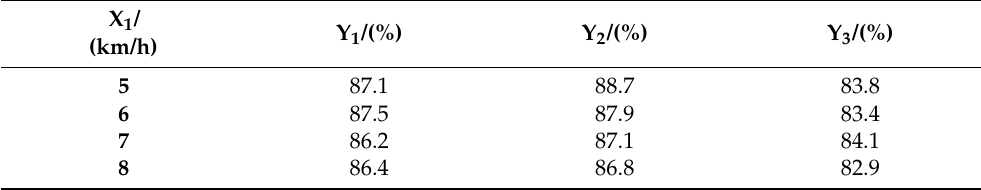
Table 8. Field validation test